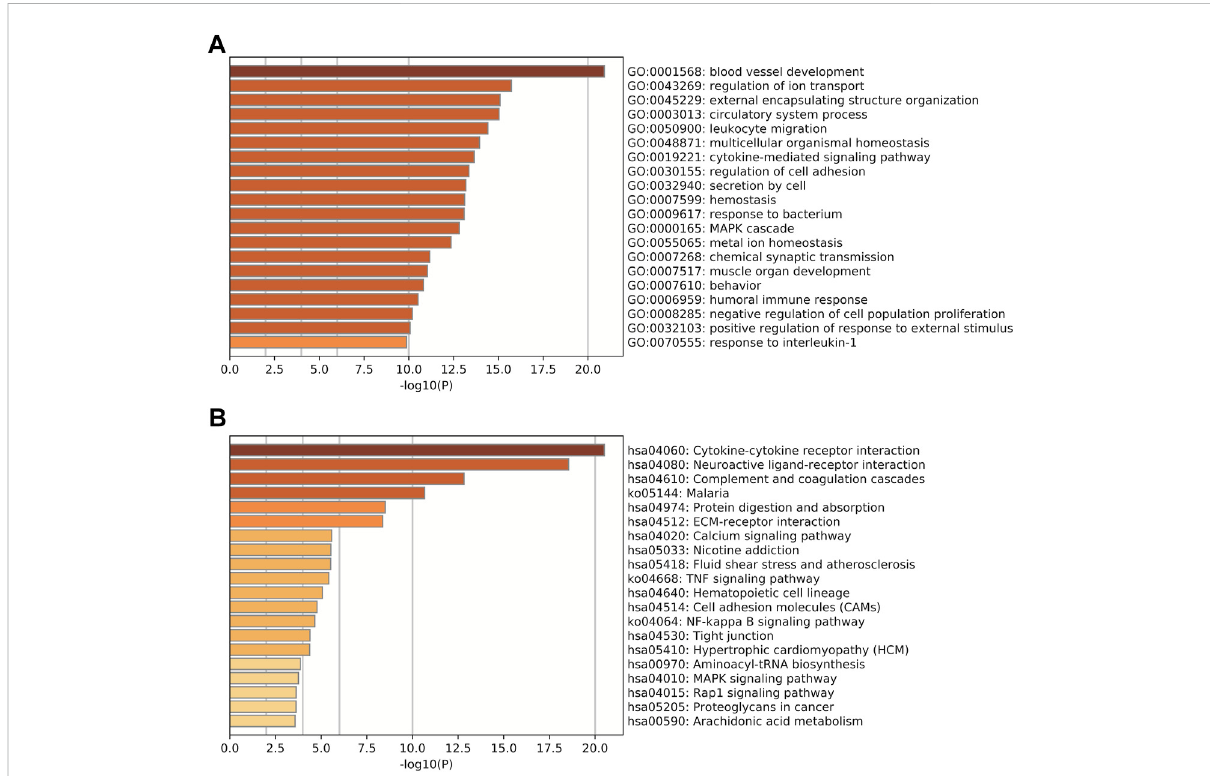
FIGURE 2 Functional annotation analysis for the validated DEmRNA gathering genes. (A) GO analysis. (B) KEGG pathway analysis. The vertical axis shows the annotated functions of the target genes. The horizontal axes show the enrichment score ( − log10 transformed p value) and the gene number of each cluster, respectively. Only the top 10 signi fi cantly enriched clusters are